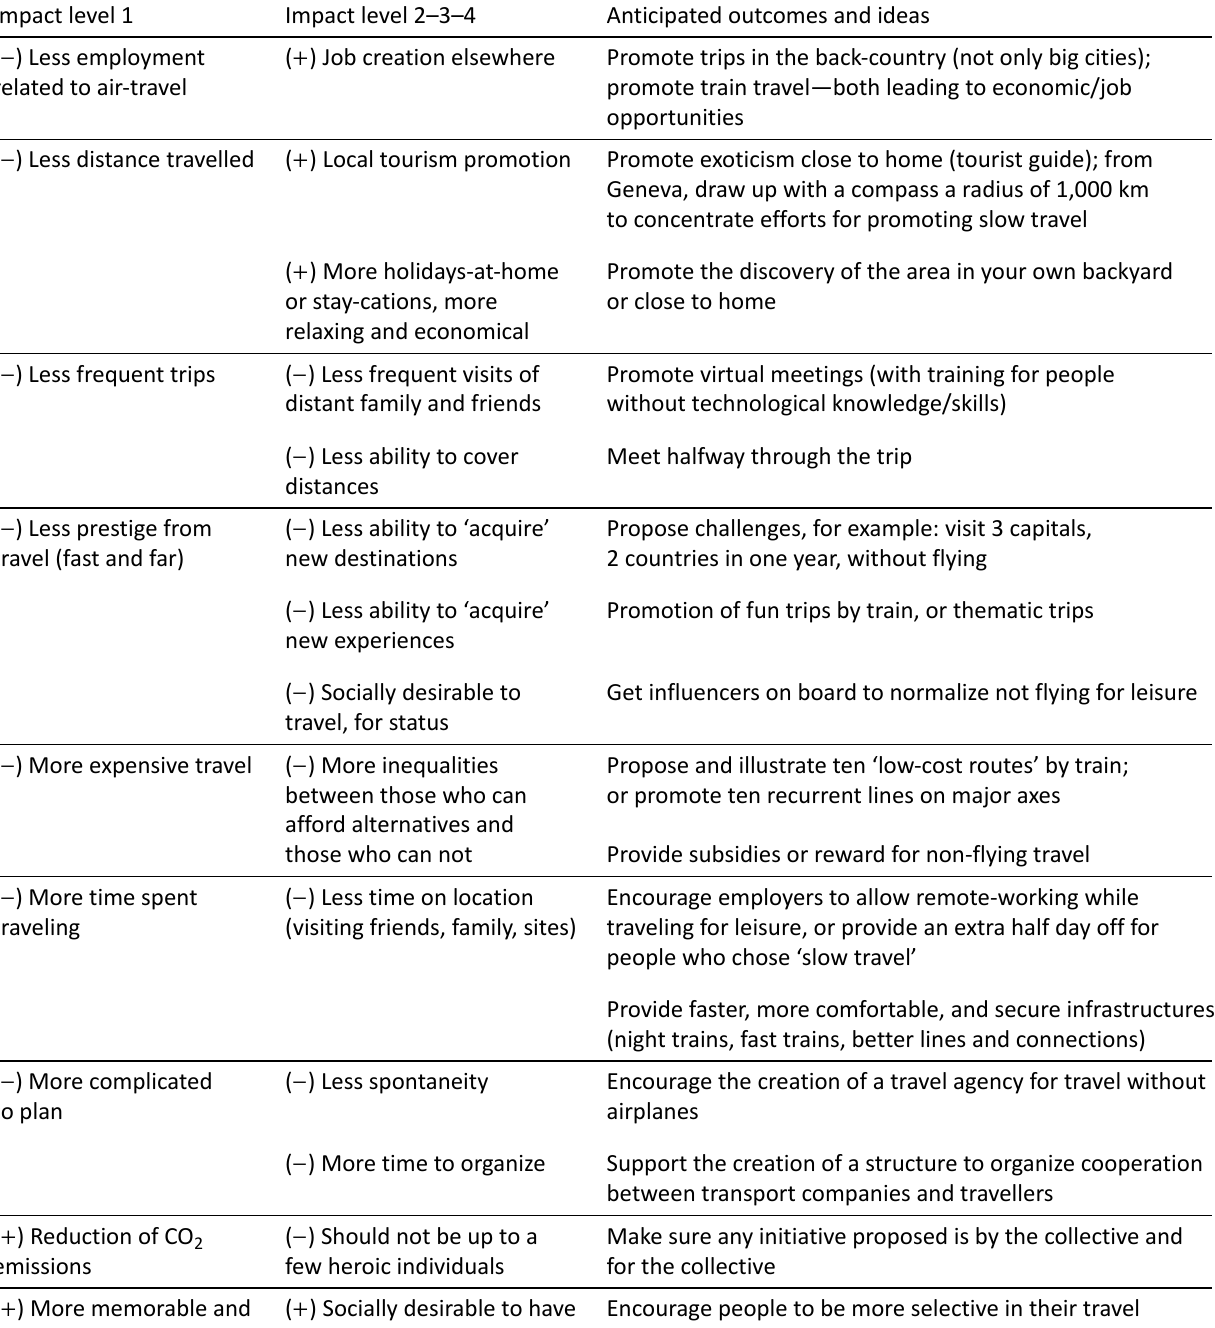
Table 3. Reducing flights for leisure travel: Different levels of negative or positive impacts and anticipated outcomes and